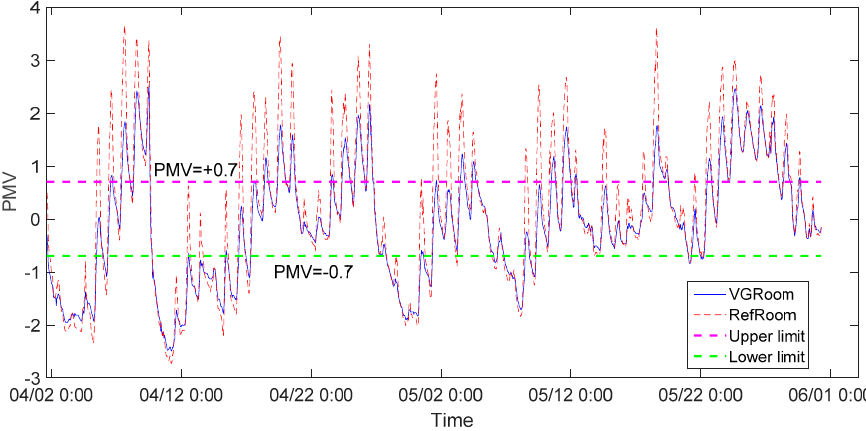
Figure 16. PMV values during the experiment.